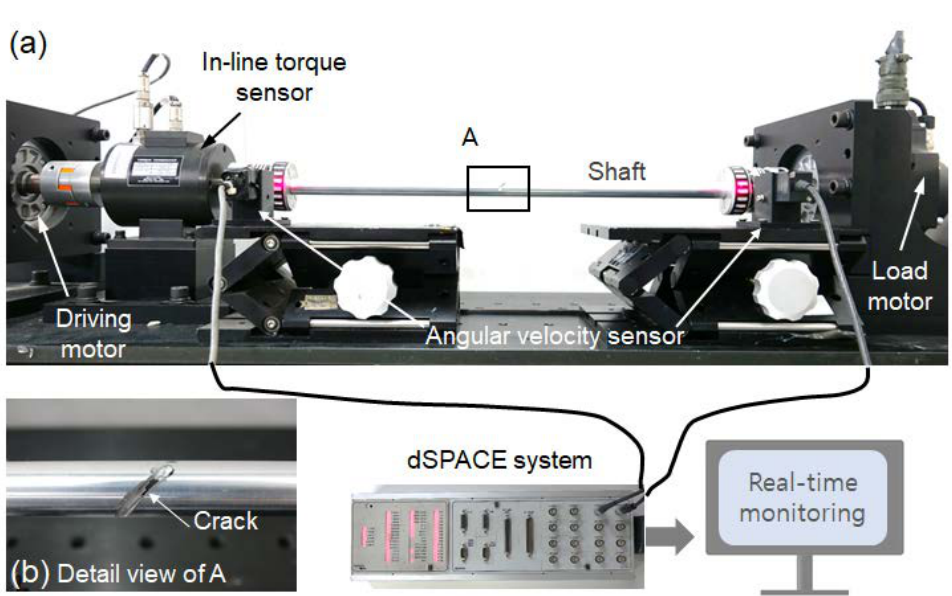
Figure 9. Schematic of experimental set-up: ( a ) overall photograph, and ( b ) details of cracked